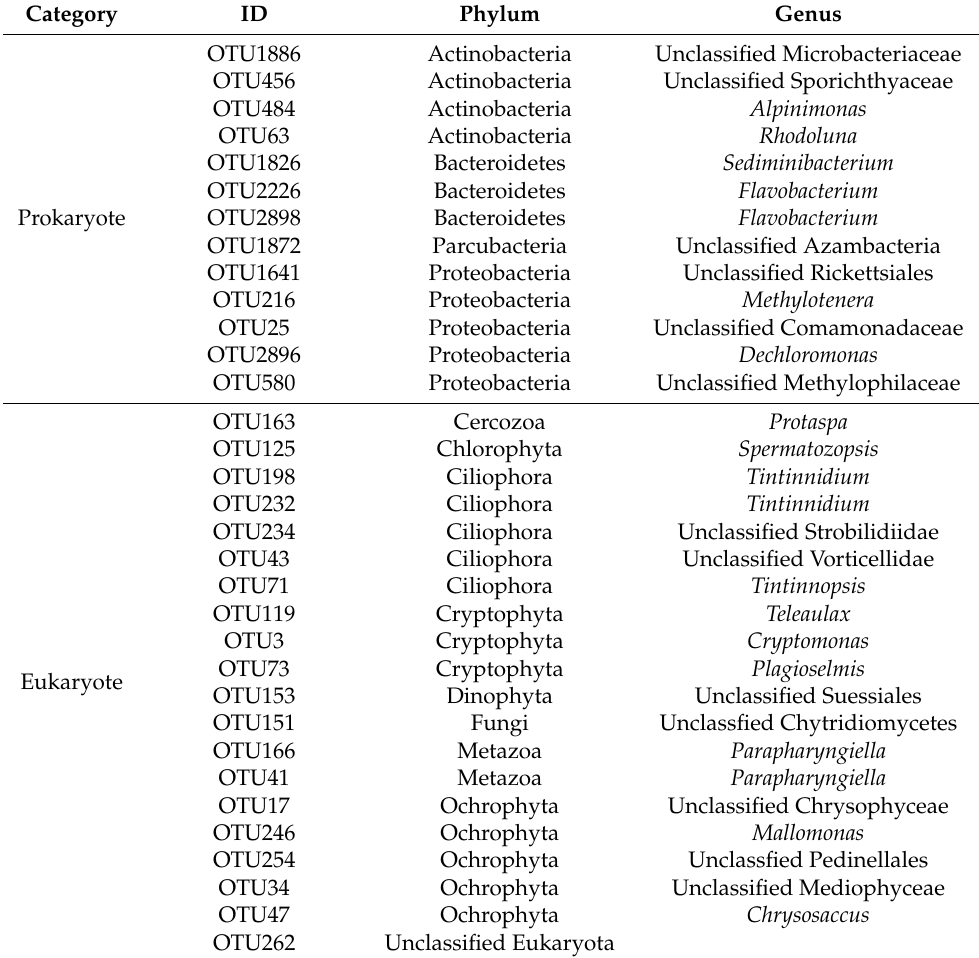
PO 4 , orthophosphate phosphorus. The green characters represent 10 samples, P represents prokary- otes from sites and E represents eukaryotes from sites. Red arrows represent measured environmental factors, blue characters represent OTUs that were strongly associated with the first two axes (fit- ness > 80%) of RDA for prokaryotes and eukaryotes, respectively. Comparison for concentration of DO and NO 2 -N from two regions ( B ). Significance determined by Wilcoxon test. P < 0.05 are considered as significant effect. Table 2. Phylum and genus of each OTU which strongly associated with the first two axes (fit- ness > 80%) of RDA for prokaryotes and eukaryotes, respectively.